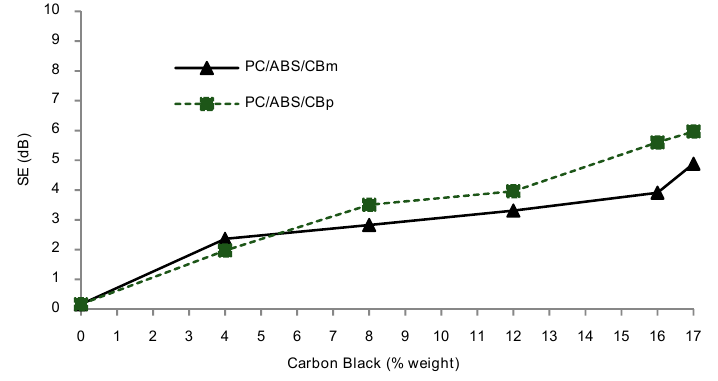
Figure 6. SE at 900 MHz with the carbon black.